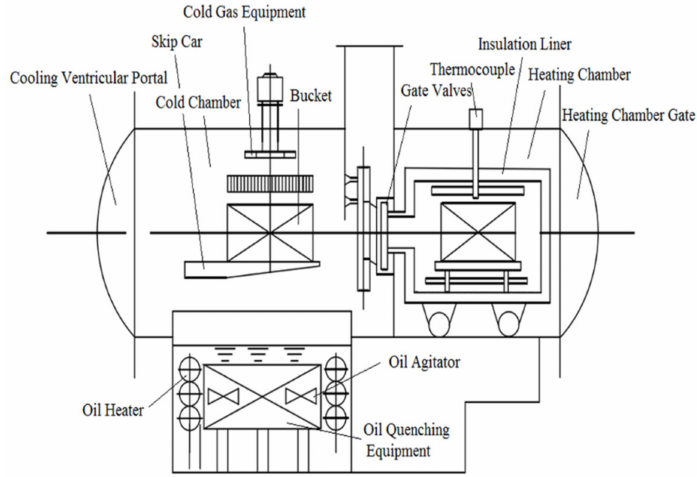
Figure 1. Sketch of the low-pressure carburizing vacuum